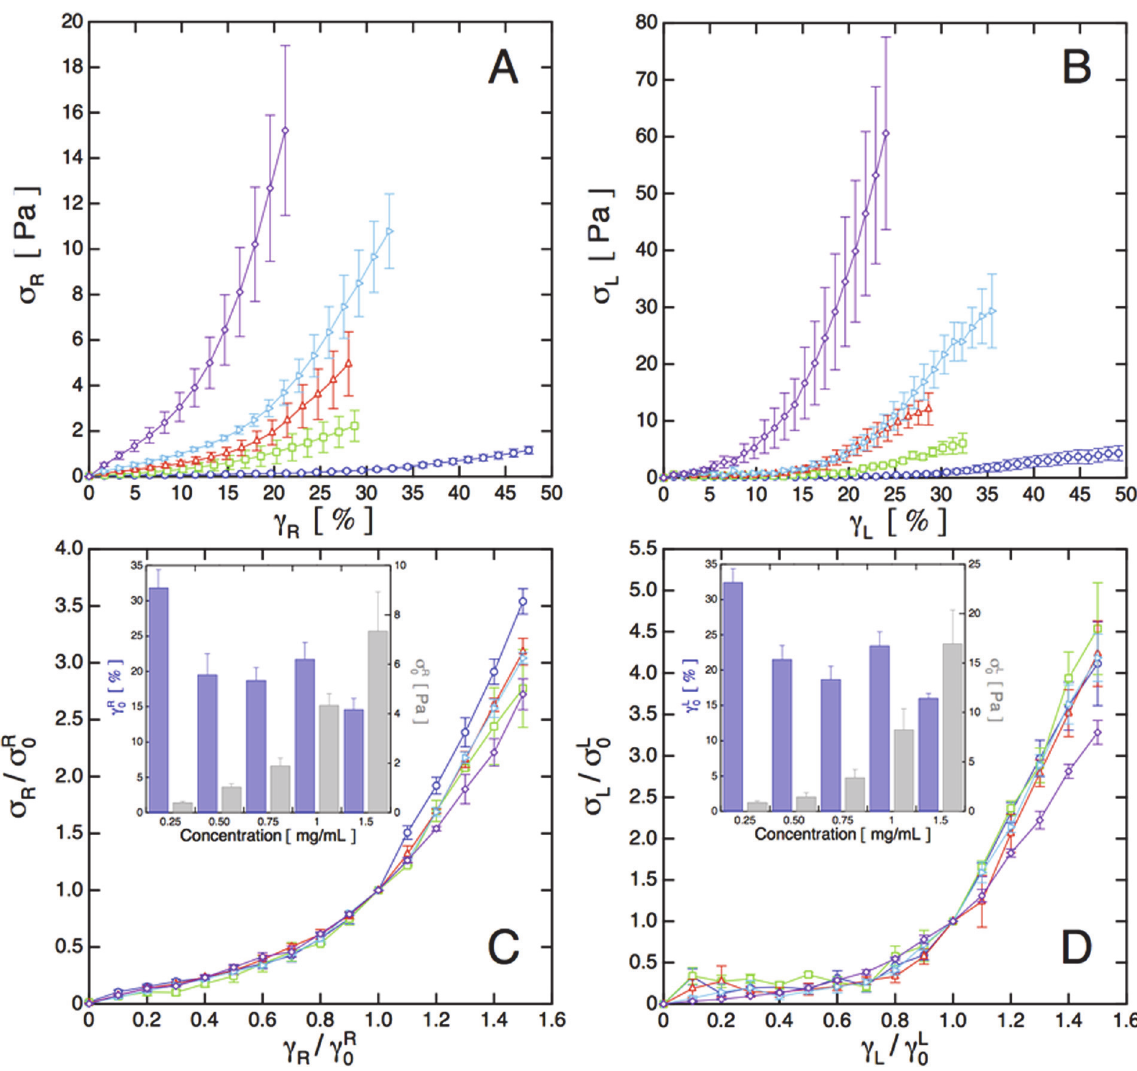
Fig 2. Bulk and local rheology of collagen gels. (A) Bulk stress-strain rheological response of the two-layer system. For all graphs, { (cid:6) , □ , 4 , ⊳ , ^ } correspond to collagen networks with concentrations c = {0.25, 0.50, 0.75, 1.0, 1.5} mg/mL. (B) Average of the local stress measured at the interface with boundary stress microcopy. (C) Rescaling the data in (A) by the stress and strain values at maximum curvature s R complete data collapse for all concentrations. (D) Rescaling the data in (B) by s L and (D) are shown in (C, inset) and (D, inset), respectively. Error bars represent standard error from {4, 3, 4, 4, 4} trials. All lines connecting points are guides for the eye.